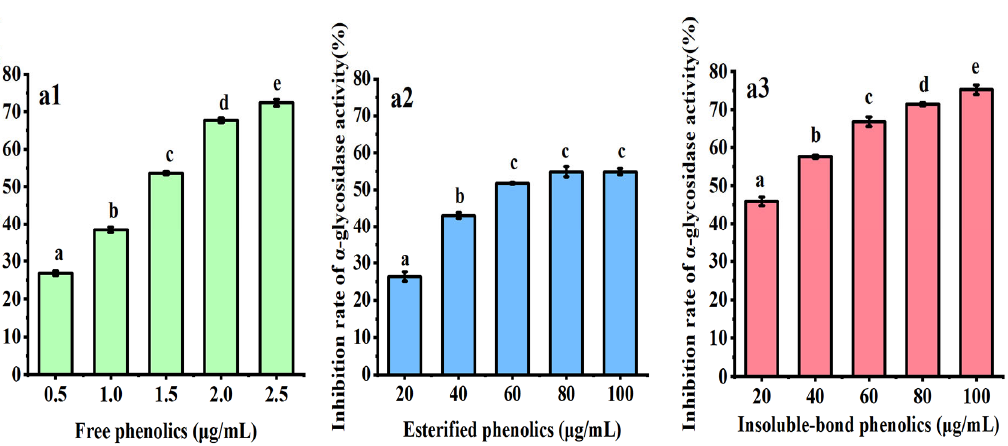
Figure 4. Inhibition rates of three phenolic fractions from water caltrop ( Trapa quadrispinosa Roxb.) husk towards α -glycosidase. ( a1 – a3 ) represent free phenolics, esterified phenolics, and insoluble- bound phenolics, respectively. All the values are expressed as mean ± SD ( n = 3). The different letters indicate significant differences ( p < 0.05).